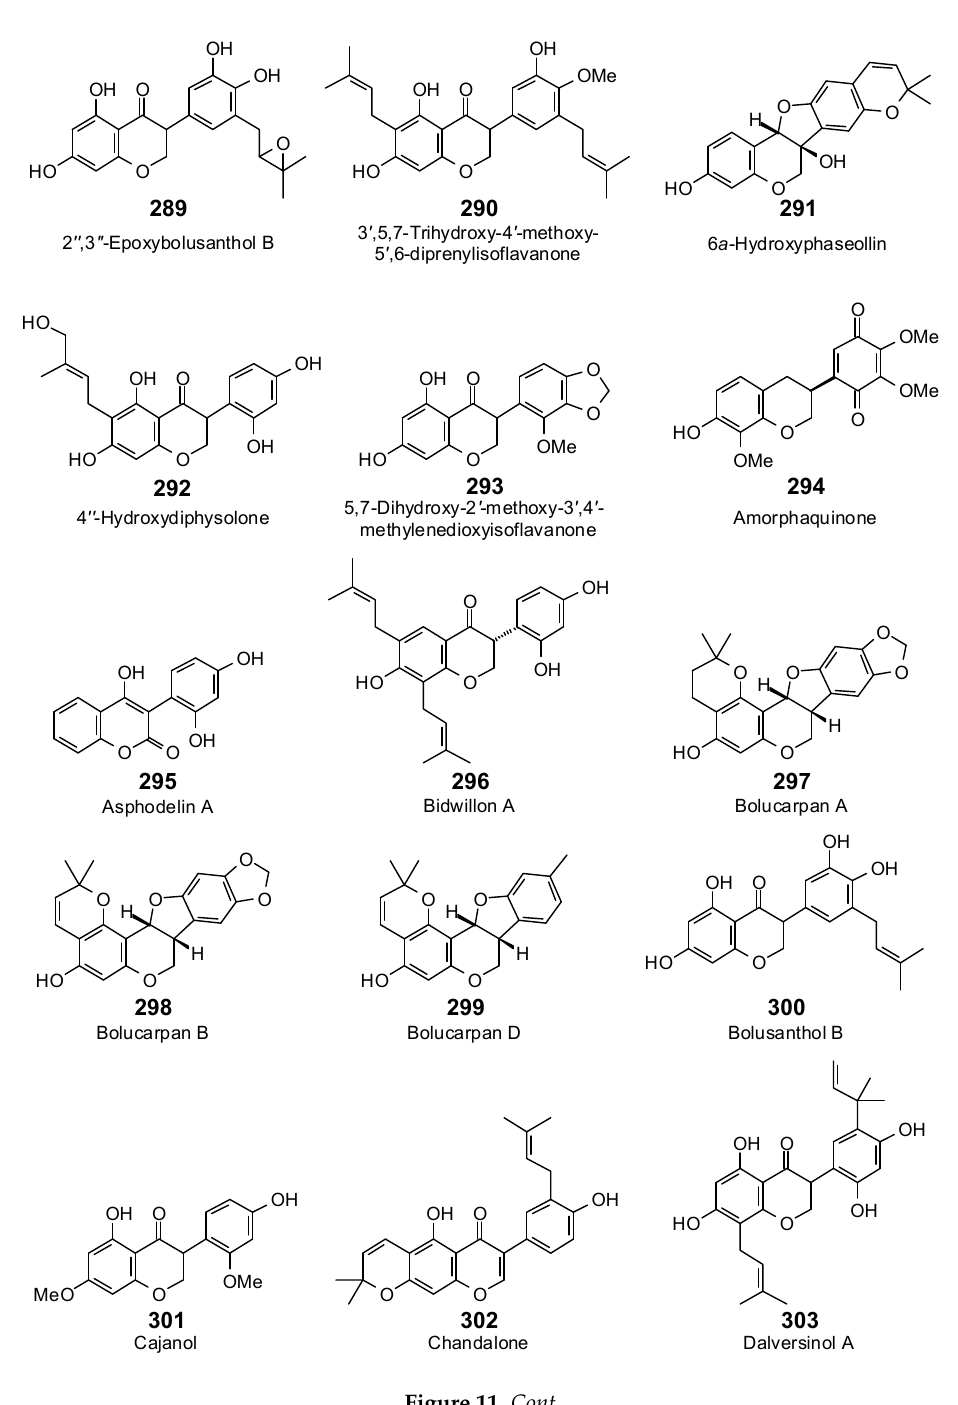
Figure 10. Flavonoids examined in this work.